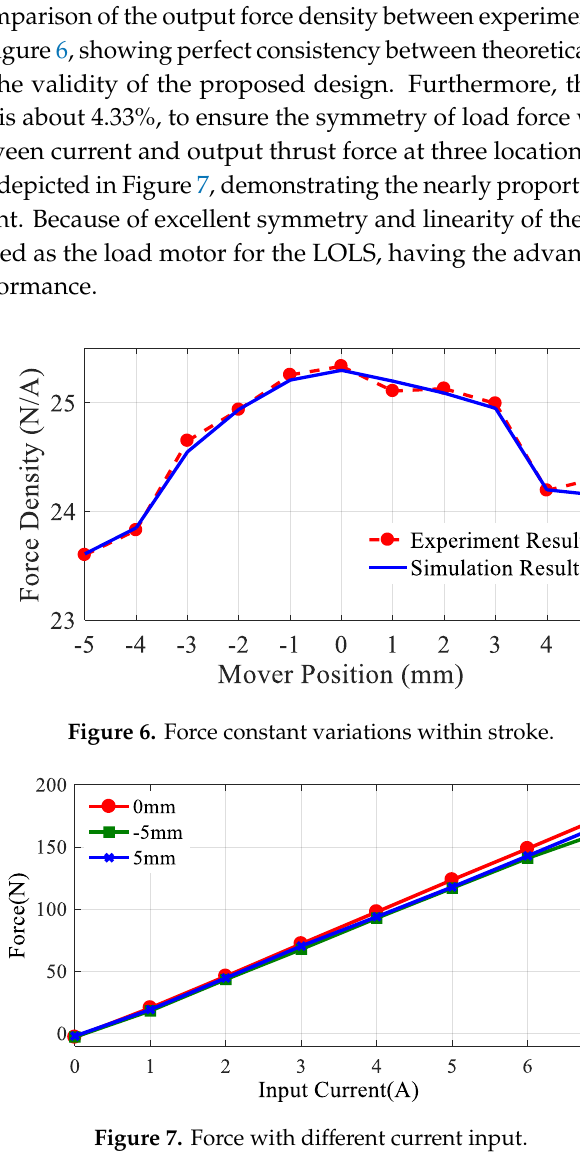
Figure 5. Detailed structure of the VCM.